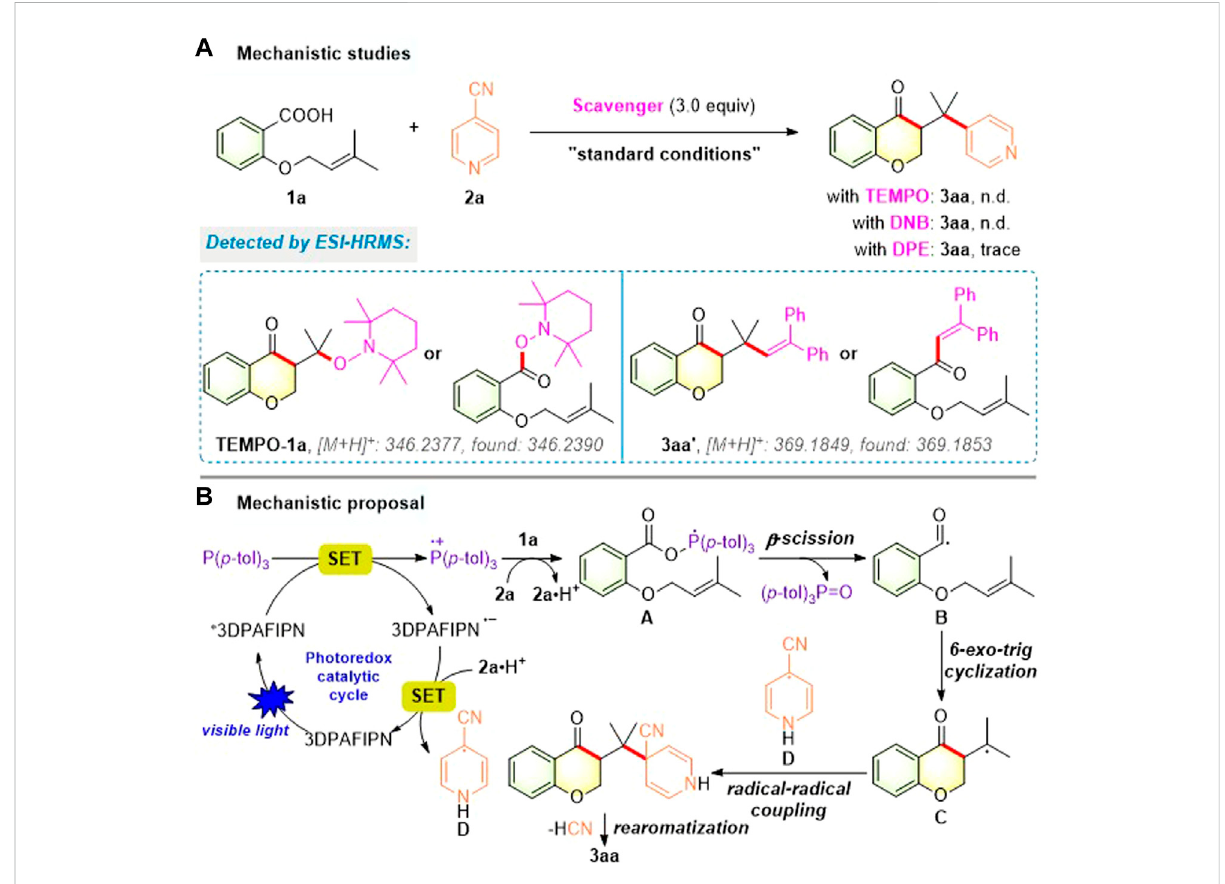
FIGURE 5 Mechanistic studies (A) and mechanistic proposal (B)